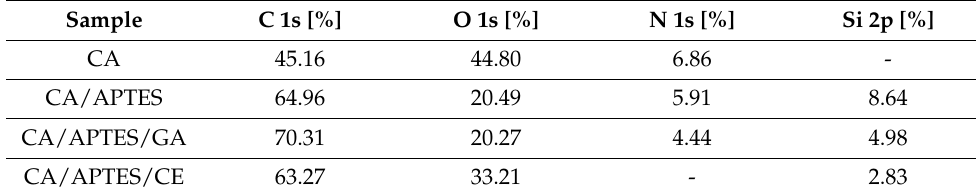
Figure 4. XPS analyses of membranes: analysis of CA, CA/APTES, CA/APTES/GA, and CA/APTES/CE, with marked peaks of interest for C 1s, O 1s, Si 2p and N 1s. Table 1. XPS atomic percentages obtained for the analyzed